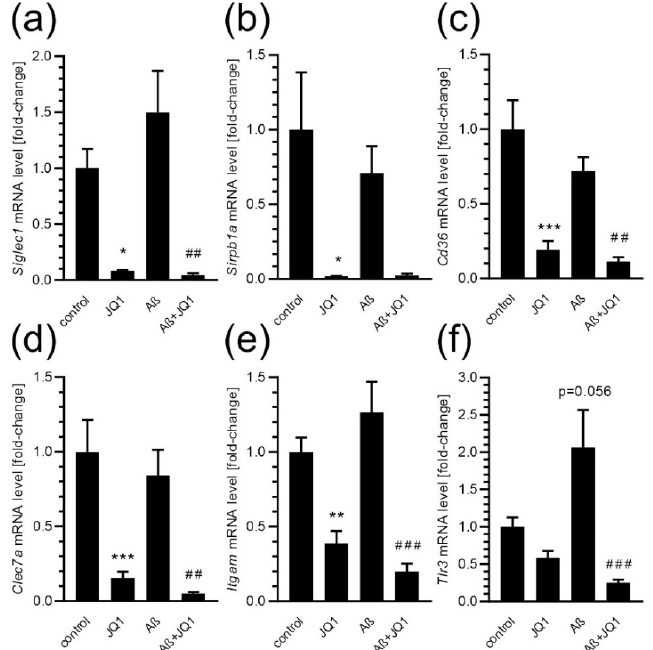
Figure 6. The effect of the BET inhibitor on microglial expression of phagocytosis-related genes. BV2 cells were incubated in the absence or presence of JQ1 for 24 h, and then A β was added for 2 h and mRNA levels for Siglec1 ( a ), Sirpb1a ( b ), Cd36 ( c ), Clec7a ( d ), Itgam ( e ), and Tlr3 ( f ) were measured using the qPCR method. Means ± SEM are presented. n = 6–8; * p < 0.05, ** p < 0.01, *** p < 0.001, compared to control, ##, ### p < 0.01 and p < 0.001, compared to A β group. Statistical analysis was performed by using a one-way ANOVA followed by the Bonferroni post hoc